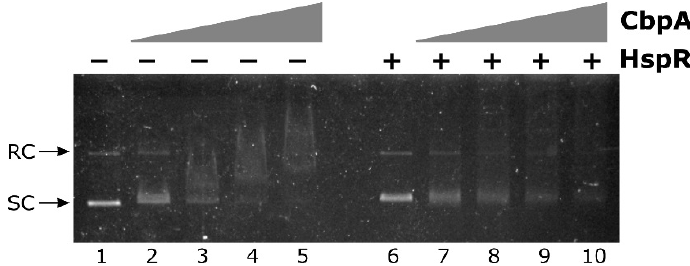
Figure 5. CbpA-HspR competitive EMSA assay. The pHel2-PflaAfur plasmid DNA probe was mixed with 0, 150, 225, 300 and 375 nM of CbpA in the presence of 300 nM of HspR (lanes 6 – 10 ) or bovine serum albumin (BSA) as control protein (lanes 1 – 5 ), incubated at 25 °C for 25 min before electrophoretic separation through 0.9% agarose gel. Symbols are as in Figure 3.